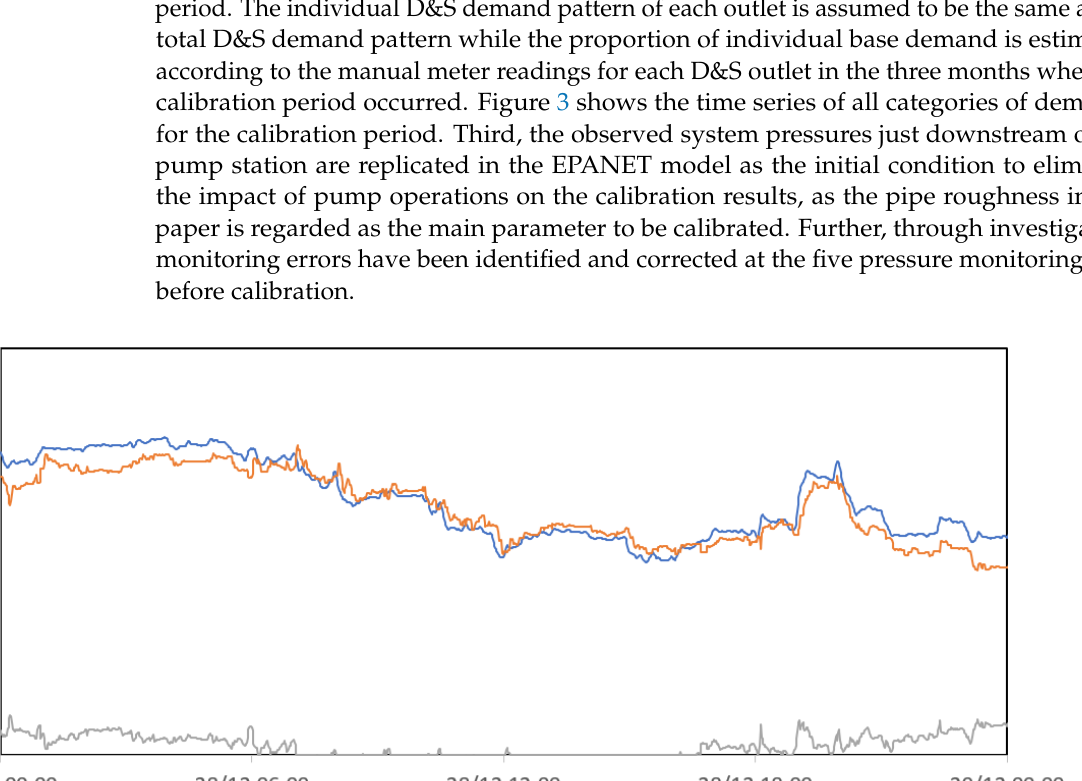
Figure 4. Total flow of each demand category during the validation period.